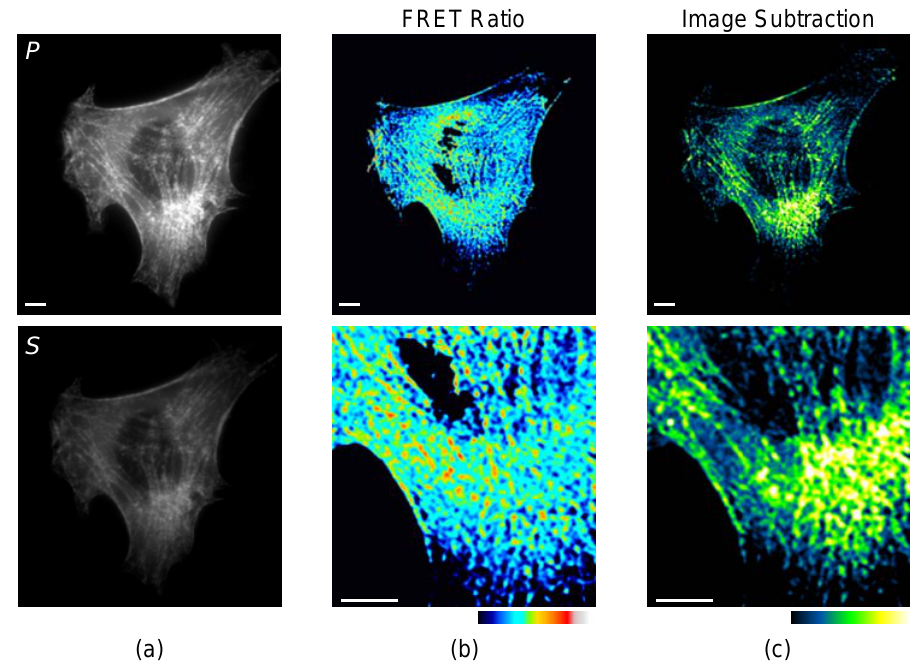
Figure 3. Image analysis of an NIH3T3 fibroblast expressing the mCerulean3 myosin II biosensor [45]. ( a ) P and S images were collected using widefield polarization microscopy; ( b ) the images can be ratioed ( P / S ) using a conventional processing strategy. Bottom shows an enlarged area of the lower perinuclear region; ( c ) alternatively, a scaled S image can be subtracted from the P image to preserve differences in sensor localization that are obscured by the intensity-independent image ratio method. Scale bars are 5 μ m.